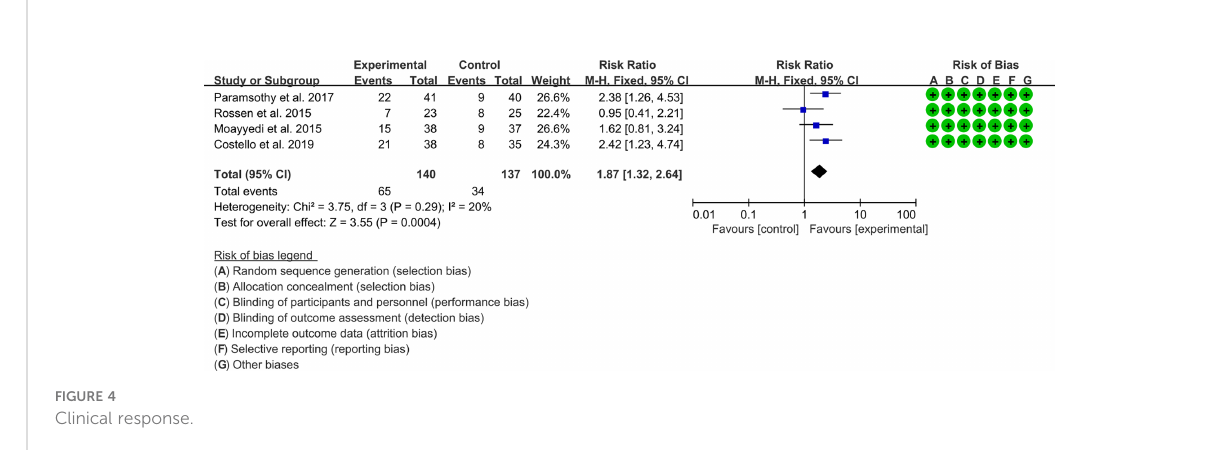
FIGURE 4 Clinical